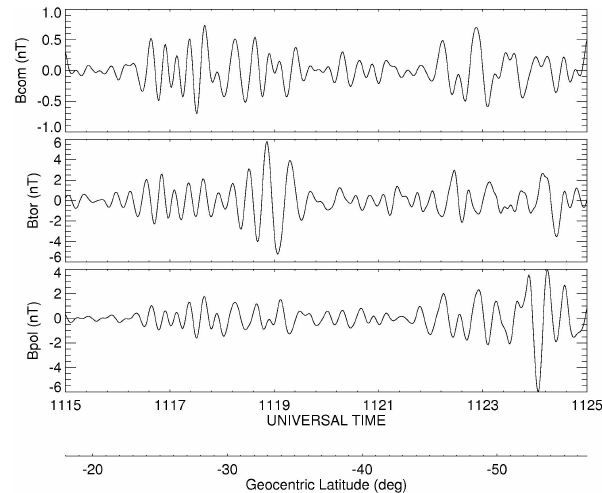
Fig. 3b. The Pc3 signal observed along the CHAMP satellite tra- jectory on 15 February 2003. The three field-aligned components, i.e. compressional ( B com ) , toroidal ( B tor ) and poloidal ( B pol ) , are shown from top to